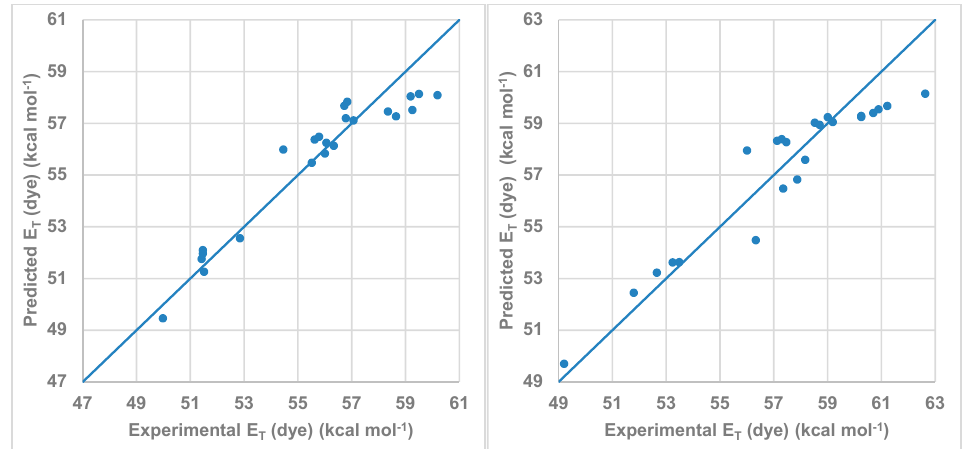
Figure 7. Model obtained using MLR for the Kamlet-Abboud-Taft scale for (left) compound 1 and Figure 8. Model obtained using MLR for the Kamlet-Abboud-Taft scale for ( left ) compound 1 and (right) for compound 2 . ( right ) for compound 2